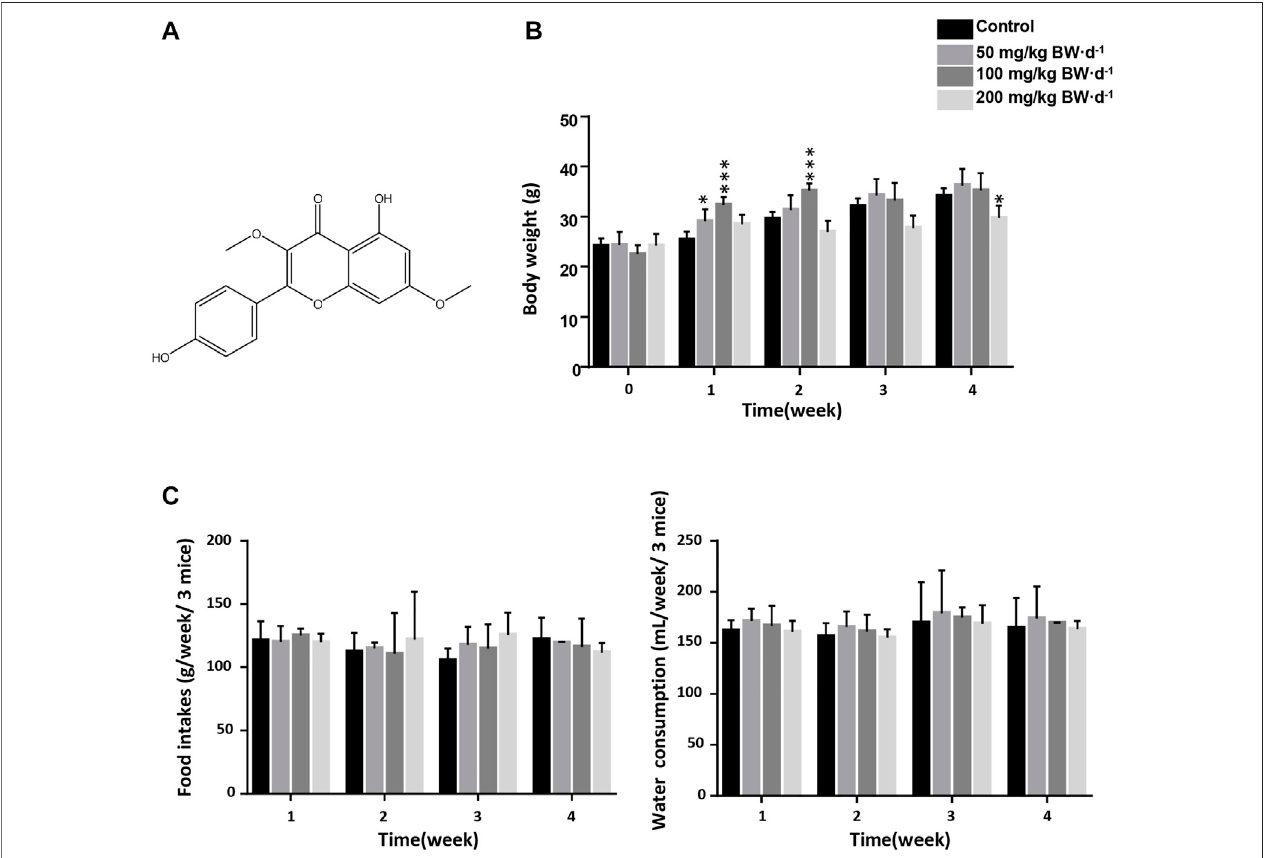
FIGURE 1 | Effect of daily oral administration of jaranol on body weight, food intake and water consumption in mice. (A) Chemical structure of jaranol. (B) Mouse body weights of different groups (n = 6). One-way One-way ANOVA followed by Tukey post-hoc test, compared with Control, * p < 0.05, *** p < 0.001. (C) Food intake and water consumption in mice, n = 2 cage, 3